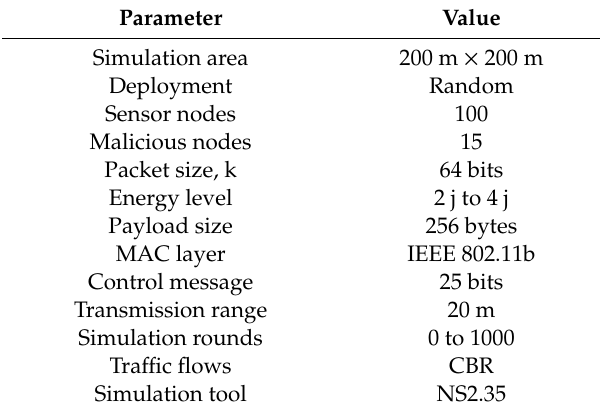
Table 1. Simulation